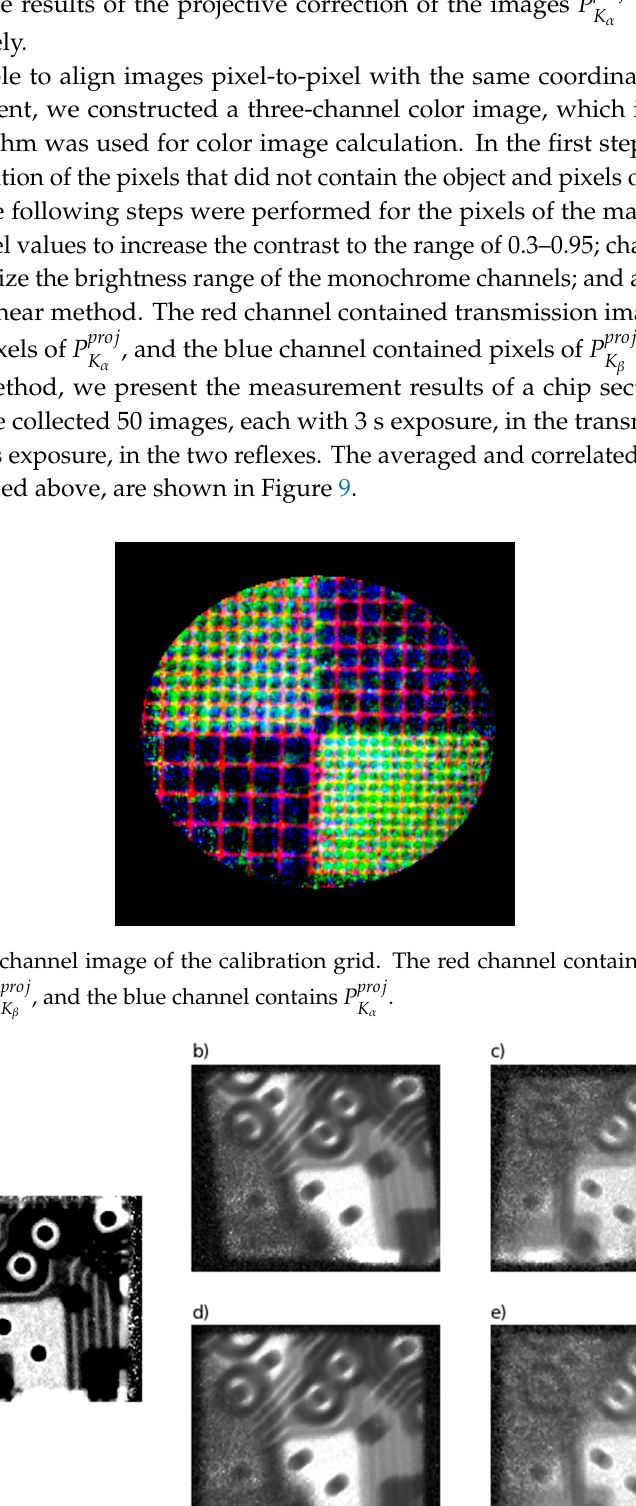
𝑛𝑜𝑟𝑚 image; ( c ) P norm picture; ( d ) after projective (cid:3041)(cid:3042)(cid:3045)(cid:3040) 𝑛𝑜𝑟𝑚 (cid:3041)(cid:3042)(cid:3045)(cid:3040) image; ( c ) 𝑃 𝐾 picture; ( d ) after K α K β image; ( c ) 𝑃 𝐾 picture; ( d ) after (cid:3328) 𝛽 (cid:3328) 𝛽 𝑝𝑟𝑜𝑗 𝑝𝑟𝑜𝑗 . K β . 𝛽 𝛽